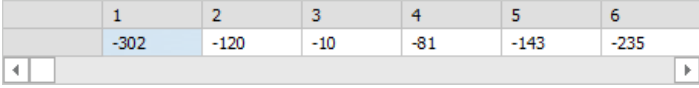
Figure 1. One - dimensional array—points (for stimulus cl201.bin). Figure 1. One-dimensional array—points (for stimulus cl201.bin).